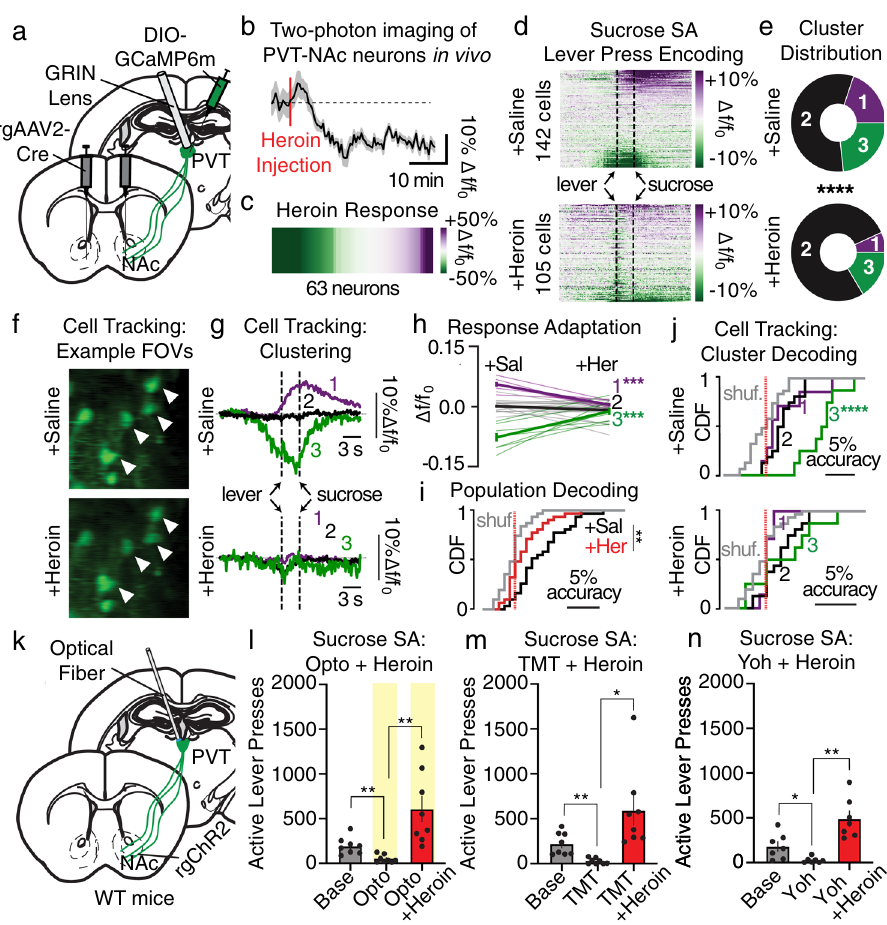
Fig. 4 | PVT → NAc-dependent suppressionofrewardseeking isdisrupted by aninjection ofheroin. a Surgeryfor in vivo two-photon imaging. b , c Averaged trace( b ) and heatmap ( c ) from two-photon imaging reveal that heroin reduced PVT → NAc neuronal activity ( n =63 neurons/3 mice; two-tailed t-test, t 62 =3.03, P =0.004). d Heatmaps for all neurons during sucrose self-administration following injection of saline (top; n =142 cells/4 mice) or heroin (bottom; n =105 cells/4 mice). e Heroin reduced the proportion of cells in excited and inhibited ensembles (Chi-squared, χ 2 =23.5, P <0.001). f Example FOVs for PVT → NAc neurons tracked across sucrose self- administration days ( n =4 mice, 31 tracked cells; top: saline, bottom: heroin). g Clustering of tracked cells revealed a change in ensemble dynamics for excitatory responders (7 cells), non-responders (16 cells), and inhibitory responders (8 cells). h Response amplitudes for tracked cells reveal signi fi cant response adaptations in ensemble1 and3,butnot2,dueto heroininjection(two-way ANOVA,ensemble ×time: F 2,56 =29.21; P <0.001;Sidak ’ spost-hoc:ensembles1, 3 P -values=0.001). i Heroin reduced active lever press decoding by PVT → NAc cells (two-way ANOVA, drug × shuf fl ing: F 1,120 =7.15, P =0.01; Sidak ’ s post-hoc: Saline vs. Heroin P =0.002). j Cluster decoding of tracked cells shows that the inhibitory ensemble best predicts an active lever during the saline test (top; two-way ANOVA, ensemble × shuf fl ing interaction: F 2,56 =7.00, P =0.002; Sidak ’ s post-hoc: P <0.001), but none of the ensembles can predict an active lever press during the heroin test (bottom; interaction: two-way ANOVA, F 2,56 =0.75, P >0.48). k Surgicalstrategyforoptogeneticmanipulation. l – n Heroinpreventedthesuppressionofsucroseself-administrationcausedbyPVT → NAc stimulation ( l ), TMT ( m ), and yohimbine ( n ) (Opto: n =8 mice/group; one-way ANOVA, F 2,21 =11.56, P =0.004; planned two-tailed t -tests: base vs. opto P <0.01, opto vs. heroin + opto P <0.01; TMT: n =8 mice/group; one-way ANOVA, F 2,21 =8.77, P =0.002; planned two-tailed t-tests: base vs. TMT P <0.01, TMT vs. heroin + TMT P <0.05; yohimbine: n =7mice/group;one-wayANOVA, F 2,18 =16.36, P <0.001;plannedtwo-tailed t -tests:basevs.yohimbine P <0.05,yohimbinevs.heroin+yohimbine P <0.01). FOV fi eld of view, SAL saline, HER heroin, Base Baseline, Opto optogenetics, Yoh Yohimbine. Group comparisons: * P <0.05, ** P <0.01, *** P =0.001, **** P <0.001. Bar and line graphs are presented as mean values±SEM. Source data are provided as a Source Data fi